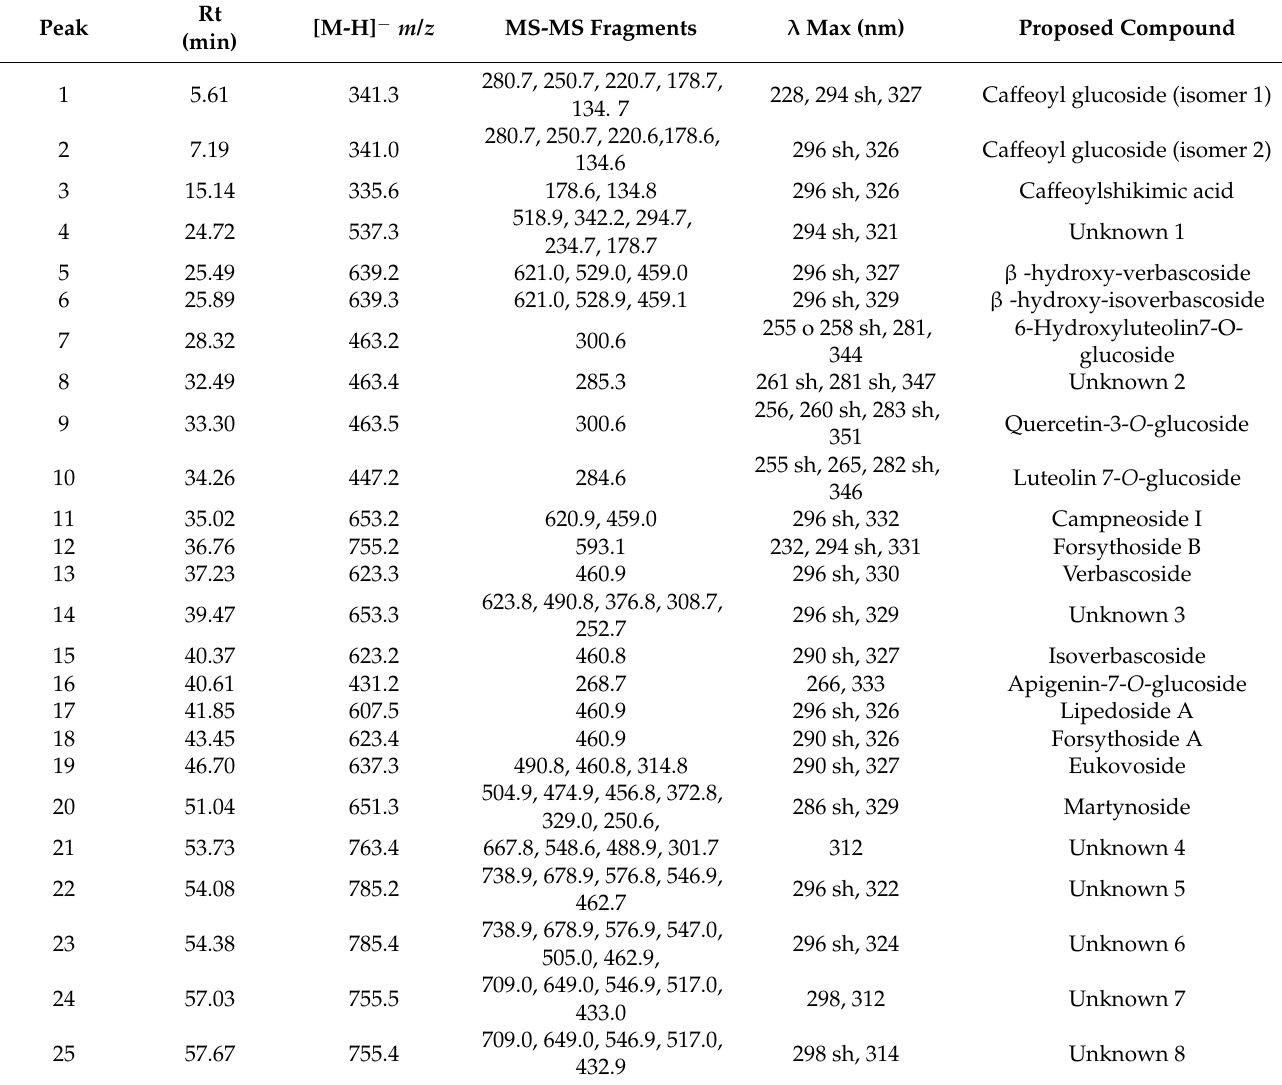
Table 1. Identification of targeted phenolic compounds from Buddleja globosa by